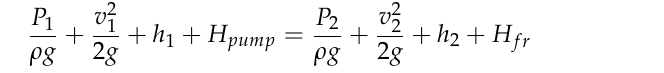
Figure 8. Exchanged heat power of the EAHE system as a function of pipes length and diameter.